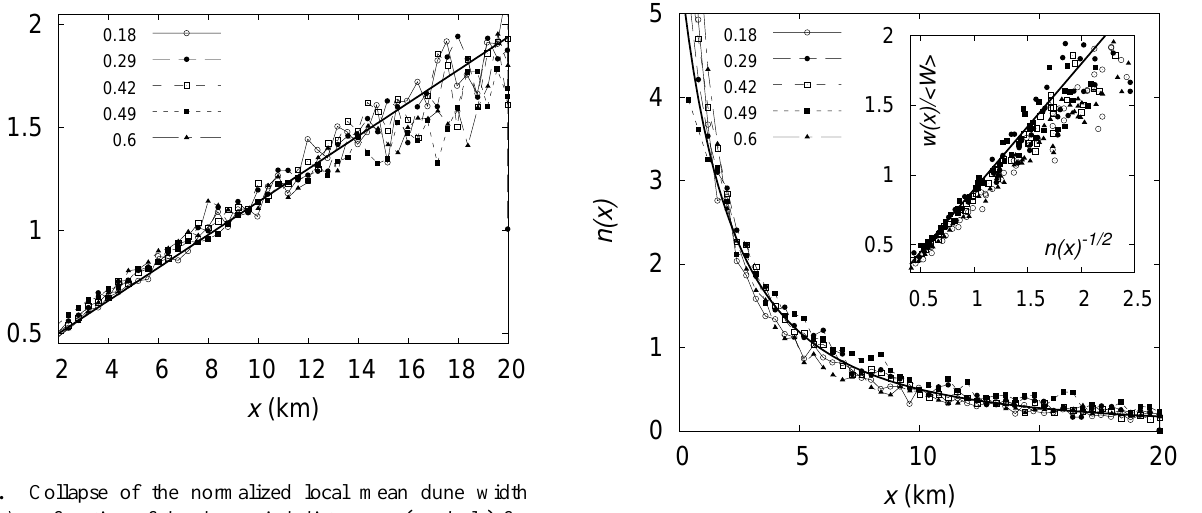
Fig. 11. Collapse of the normalized local mean dune width w(x)/ h w i as function of the downwind distance x (symbols) for different boundary conditions, e.g. a different input dune density ρ 0 . The solid line corresponds to the linear fit. h w i is the mean dune size in the whole field.